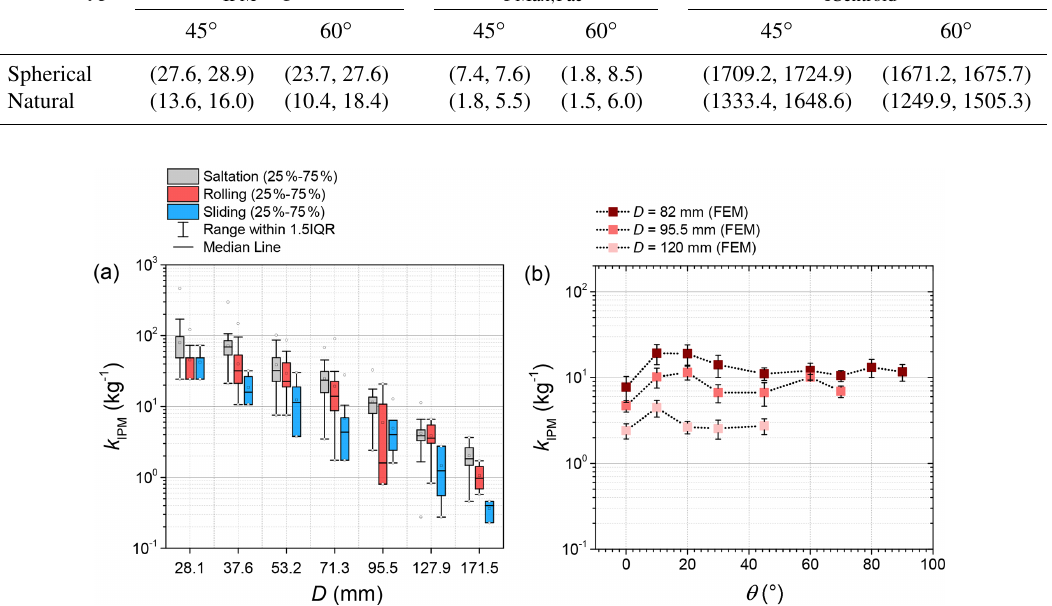
Figure 8. (a) Impulse-mass coefficient k IPM versus bedload particle size D ( b axis) for different transport modes. (b) Impulse-mass coeffi- cient k IPM versus the impact angle θ for different impacting particle sizes. FEM denotes simulations with the finite element method.